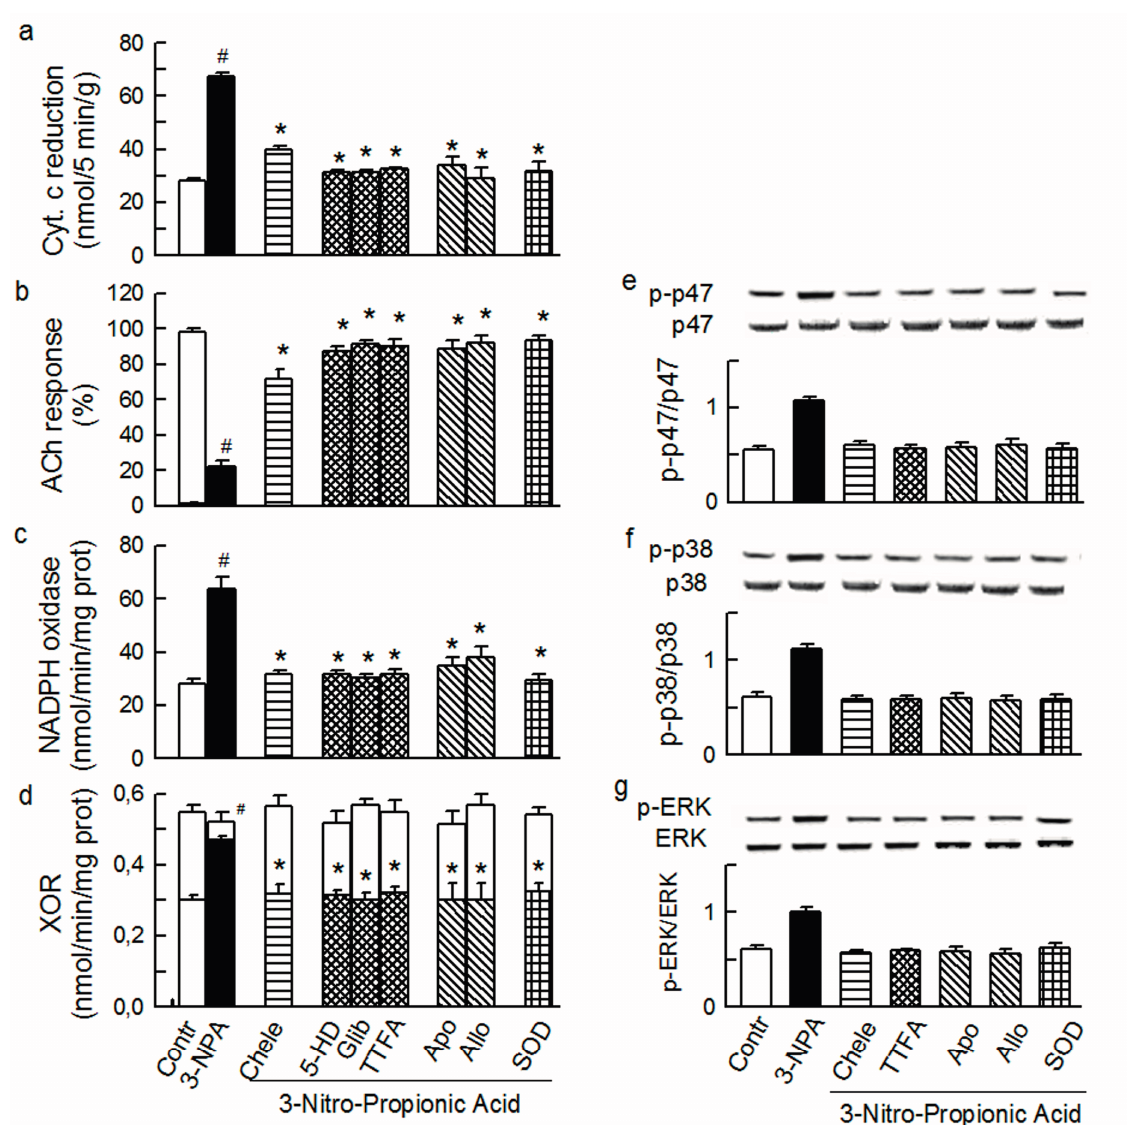
Figure 8. Effect of 3-Nitro-Propionic Acid (3-NPA, 5 mM) on the total outflow of reduced cytochrome c ( a ); normalised acetylcholine (ACh) response ( b ); NADPH oxidase activity ( c ); xanthine oxidoreductase activity (XOR) ( d ); phosphorylation of Ser345-p47phox ( e ), p38 ( f ) and ERK1/2 ( g ) in guinea-pig hearts. 3-NPA was administered either alone or in combination with (from left to right): 4 μ M chelerythrine (Chele), 100 μ M 5HD, 3 μ M glibenclamide (Glib), 5 μ M TTFA, 1 mM apocynin (Apo), 250 μ M allopurinol (Allo), and 150 IU/mL SOD. Values are means ± SEM of at least five experiments in a – d and of four experiments in e – g . # p < 0.05 vs. control; * p < 0.05 vs.